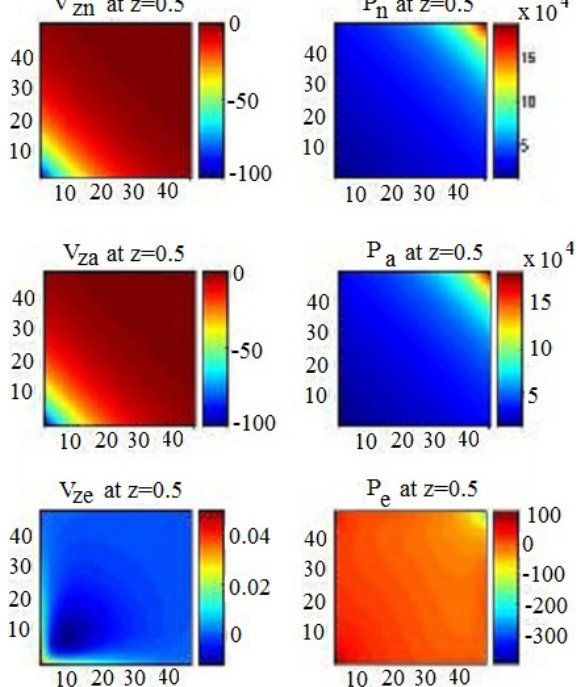
Figure 9. Distribution of v z and P ; 3-D case, exponentially vary- ing viscosity, high-viscosity contrast ( η 2 = η 3 = η 4 = 100), v ze = v zn − v za , P re = P rn − P ra .